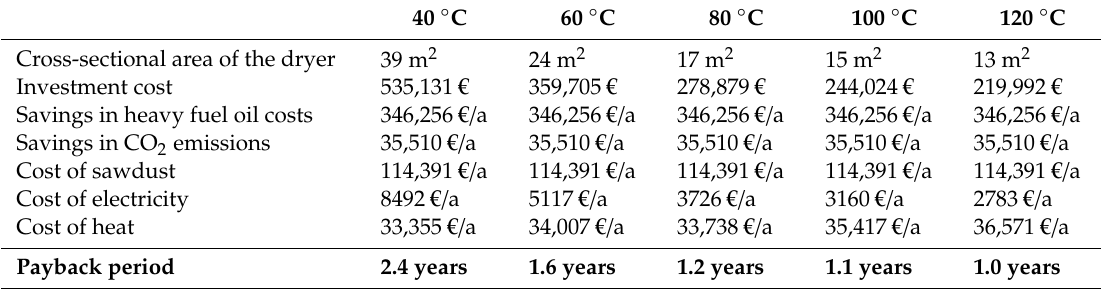
Table 6. The payback period calculations for the base case when the current import price of the heavy fuel oil (410 € / t-oil, [31]) has been used (The term € / a represents the term € / years).